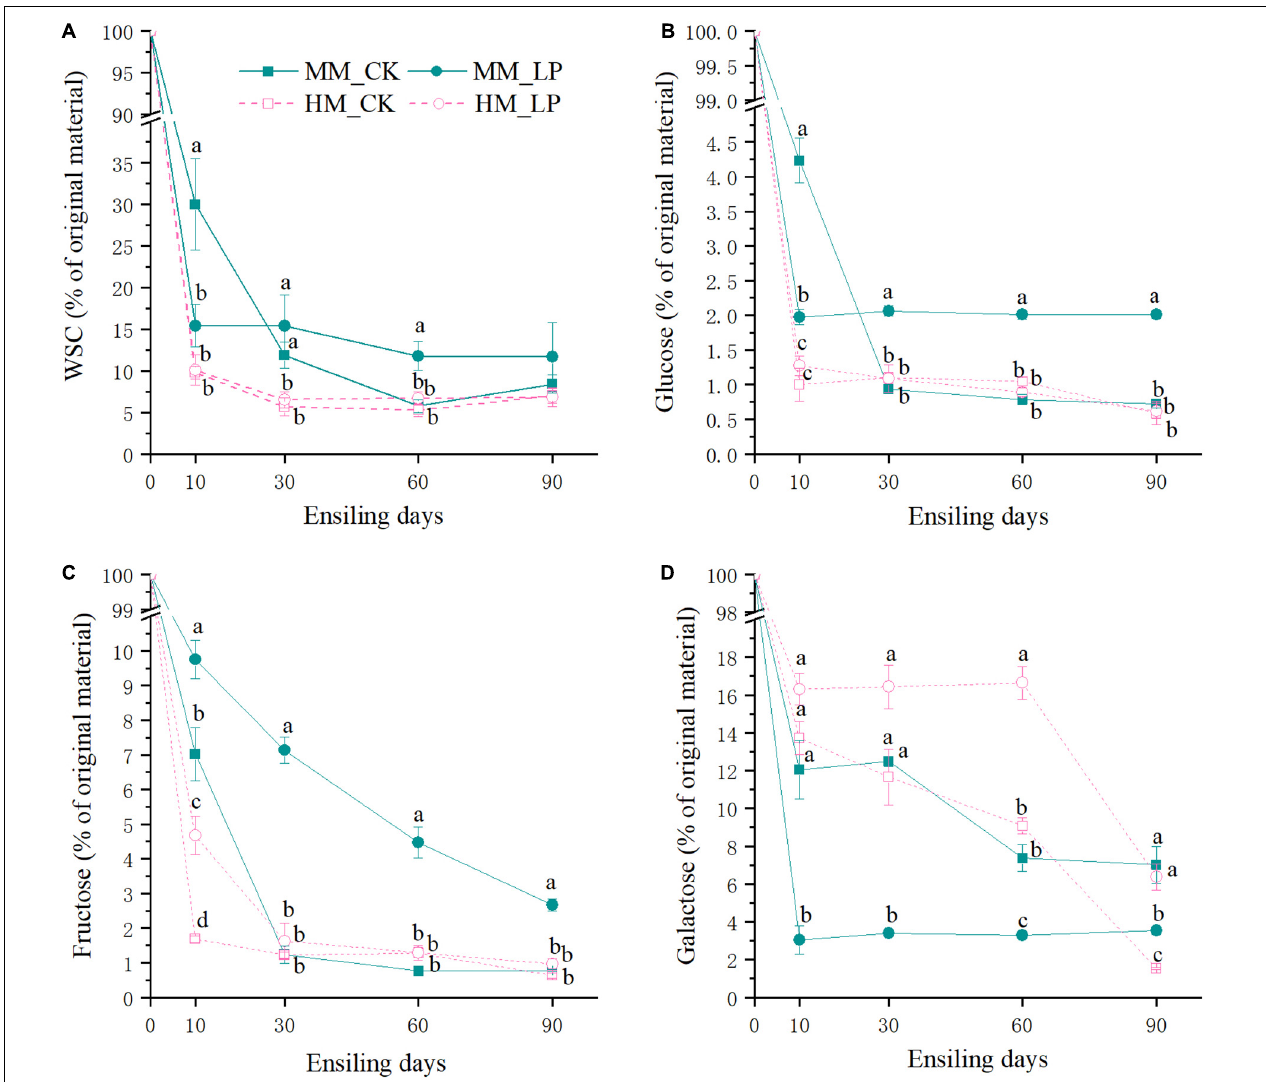
FIGURE 3 | Dynamics of residual WSC (A) , glucose (B) , fructose (C) , and galactose (D) during ensiling and expressed as percentage in the parent material. Compositions of WSC and monosaccharide in the non-wilted and wilted alfalfa prior to ensiling served as 100%. HM, not wilted before ensiling; MM, wilted before ensiling; CK, silage without inoculation; LP, silage inoculated with L. plantarum A345. Means with different small letters represents significant difference among treatments at the same ensiling period at P < 0.05 ( n = 3, bars indicate standard error of